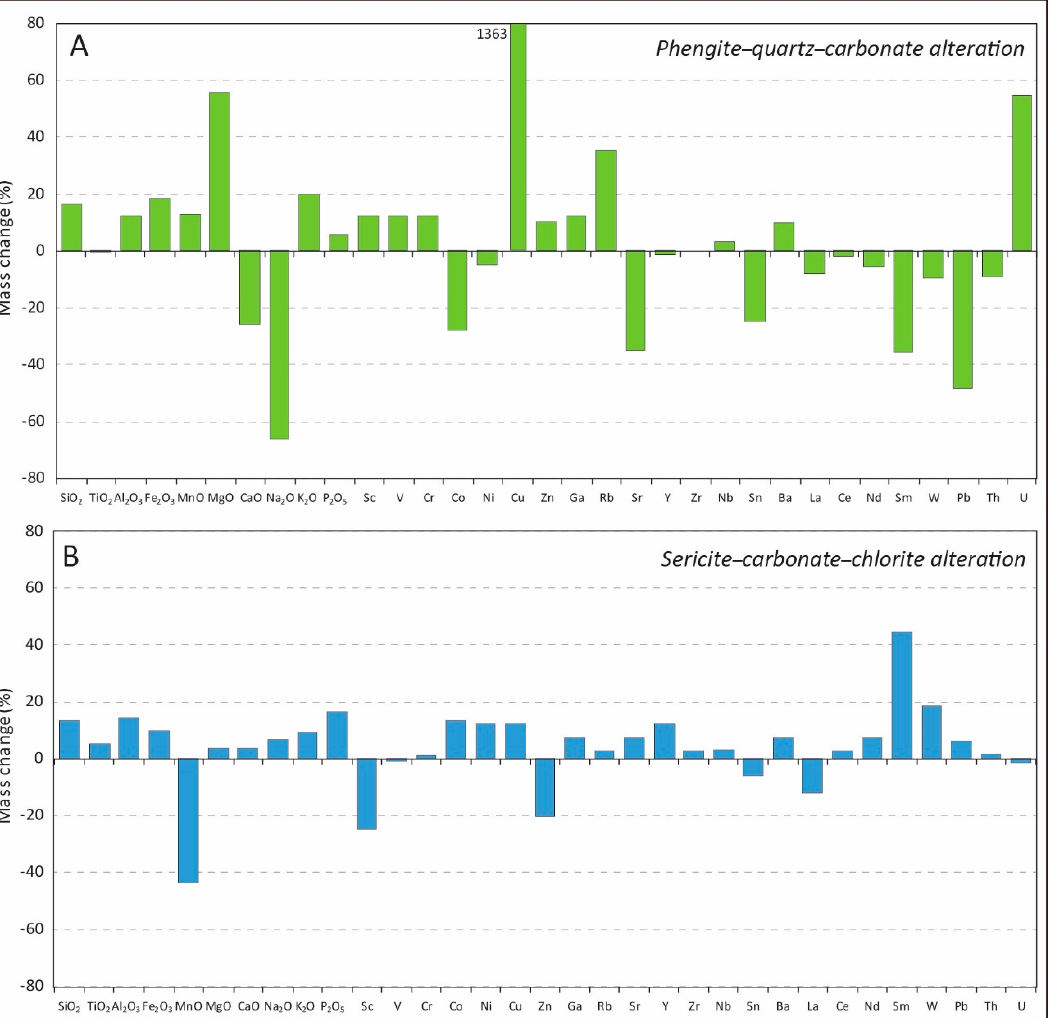
Figure 13. Mass balance diagrams—gain and loss for ( A ) phengite–quartz–carbonate and ( B ) sericite–carbonate–chlorite alterations.